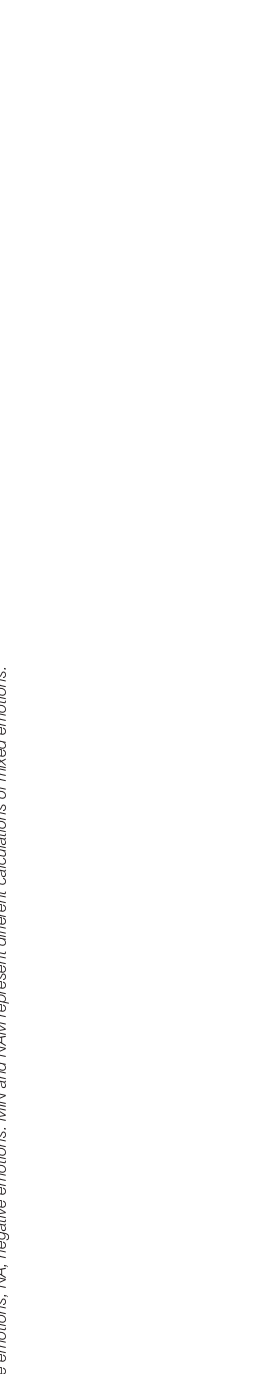
FIGURE 1 | Cultural and situational differences in discomfort induced by conflict stimuli. Condition means of discomfort in predominantly pleasant situation and predominantly unpleasant situation. Error bars indicate 1 standard error of the mean (SE). PPS, predominantly pleasant situation; PUS, predominantly unpleasant situation.** p <